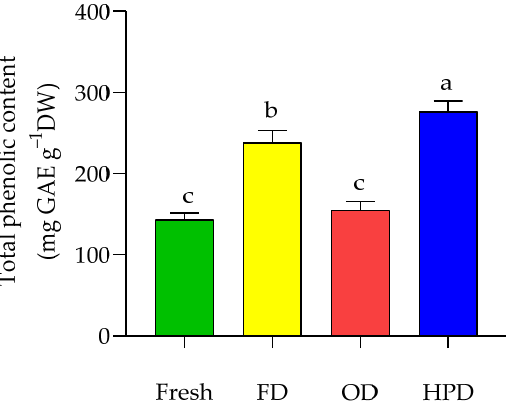
Figure 1. Total phenolic content of fresh or dried leaves of U. dioica plants collected in the wild. Leaves were dried with different methods: freeze-drying (FD), oven-drying (OD) and heat pump drying (HPD). Means keyed with a different letter are significantly different for p = 0.05 following least significant difference (LSD) test.